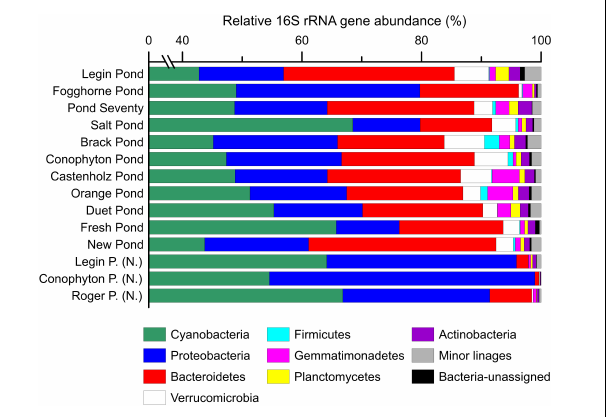
FIGURE 2 | The relative abundance (%) of bacterial 16S rRNA genes in microbial mat communities. Shown are the major bacterial phyla. Samples with sub-fix (N.) indicate ‘Nostoc spheres,’ which were collected in three different meltwater ponds. Detailed results from the 16S rRNA gene sequencing are provided in the supporting information. Note the broken axis between 1 and